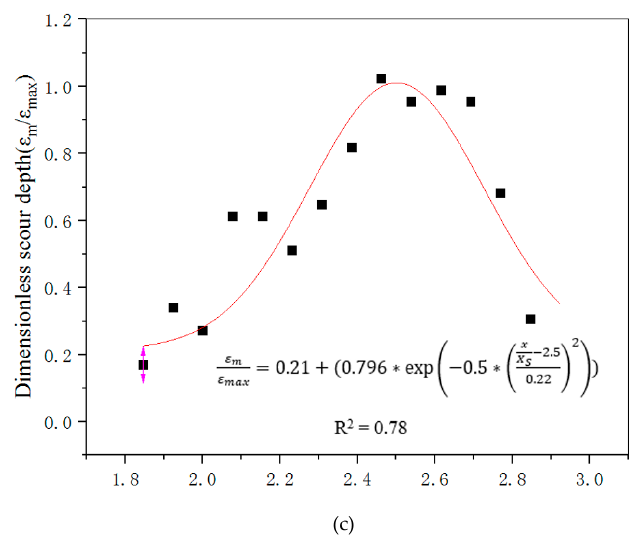
Figure 9. Dimensionless scour section of different zones. ( a ) Small scour hole ( ‐ 0.5 < X/X m < 0); ( b ) primary scour hole (0 < X/X m < 1.8); ( c ) deposition dune (1.8 < X/X m < 3). The entire scour profile can be predicted by using Equations (5)–(7).